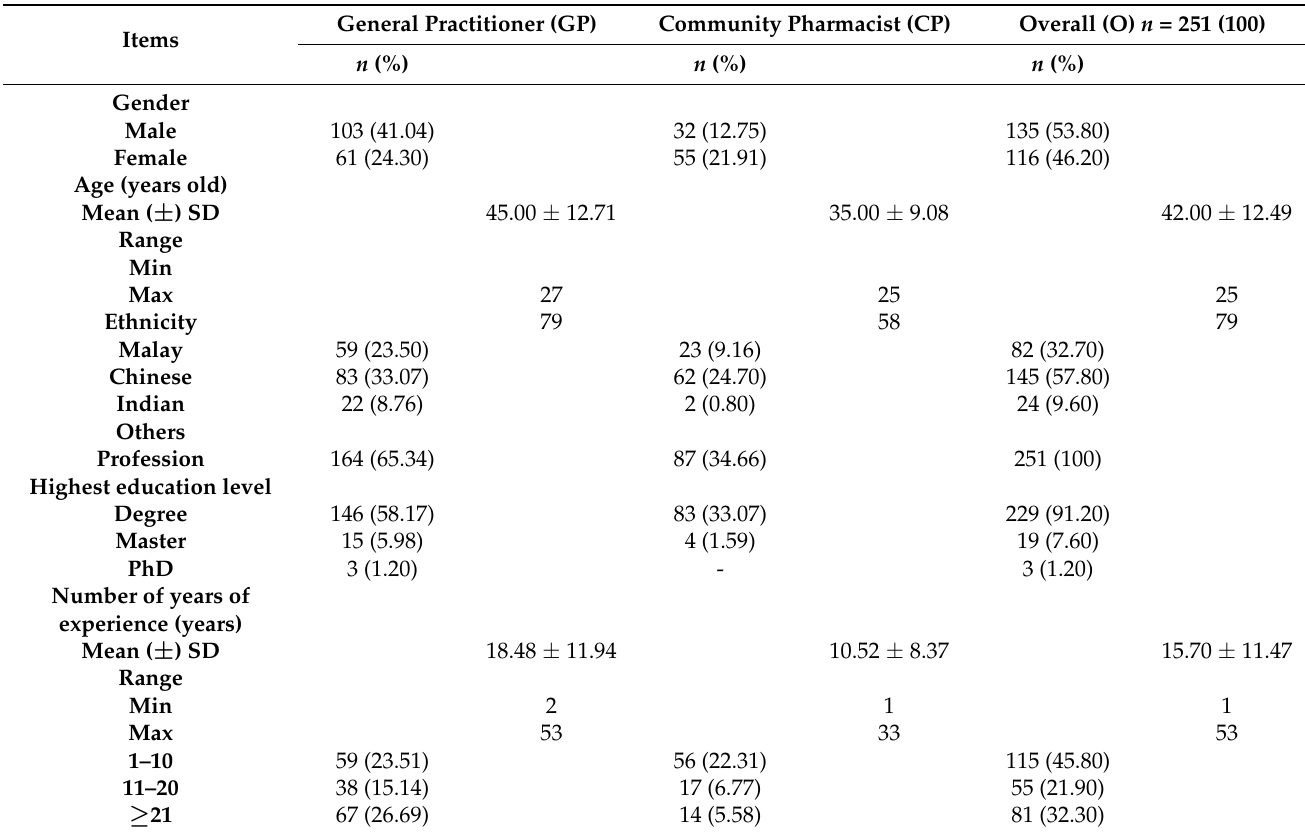
Table 1. Socio-demographic characteristics of study